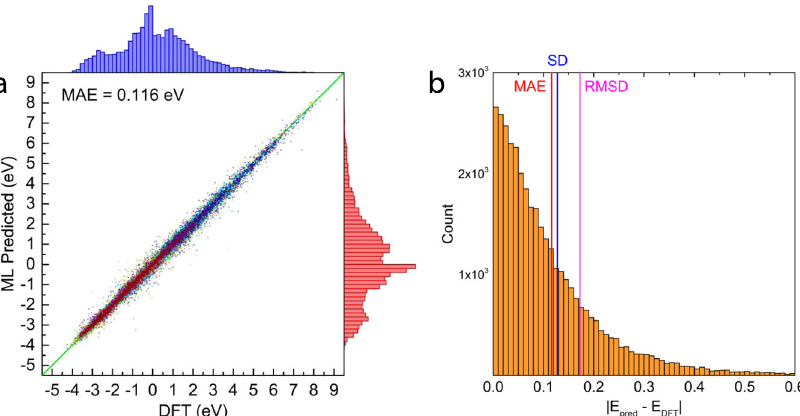
Fig. 3 DOSnet performance on the combined dataset. a Parity plot and histogram between the DFT-calculated and DOSnet predicted energies on all 35,000 entries from fi vefold cross-validation. b Histogram of prediction residuals.